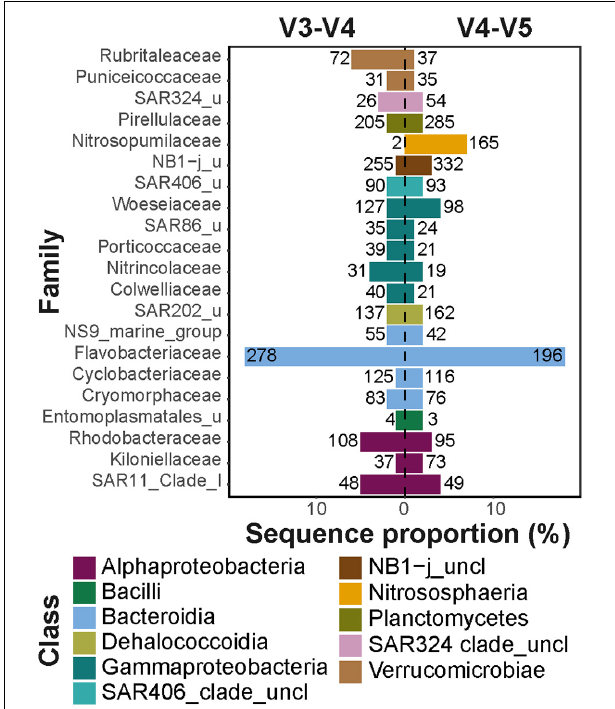
FIGURE 2 | Major taxonomic families in V3–V4 and V4–V5 datasets. The x -axis represents the total sequence proportion of each family in V3–V4 (left panel) and V4–V5 (right panel) datasets. The numbers at each column represent the number of observed ASVs affiliated with each taxonomic family. Different taxonomic classes are represented by color code. Only families that comprised at least 1% of sequences in at least one of the datasets were included in the